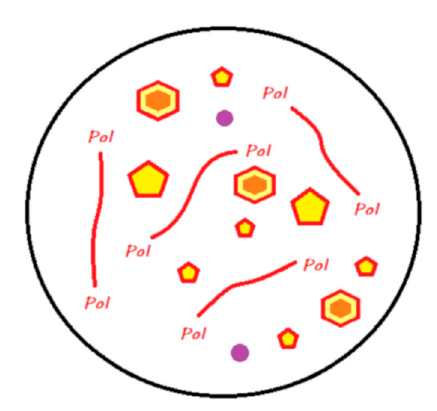
Figure 13. A giomer in its storage medium. This material contains, schematically, a silane-treated partially pre-reacted FAS filler (S-PRG), an unreactive filler, and a blend of monomers and